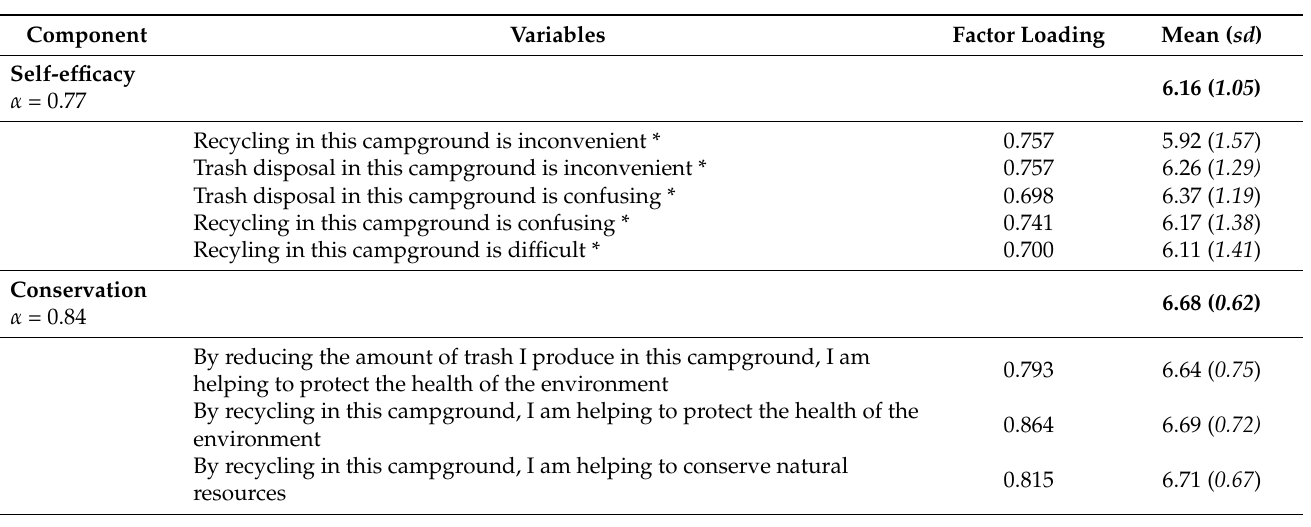
Table 3. Additional Cognitive Measures 1,2